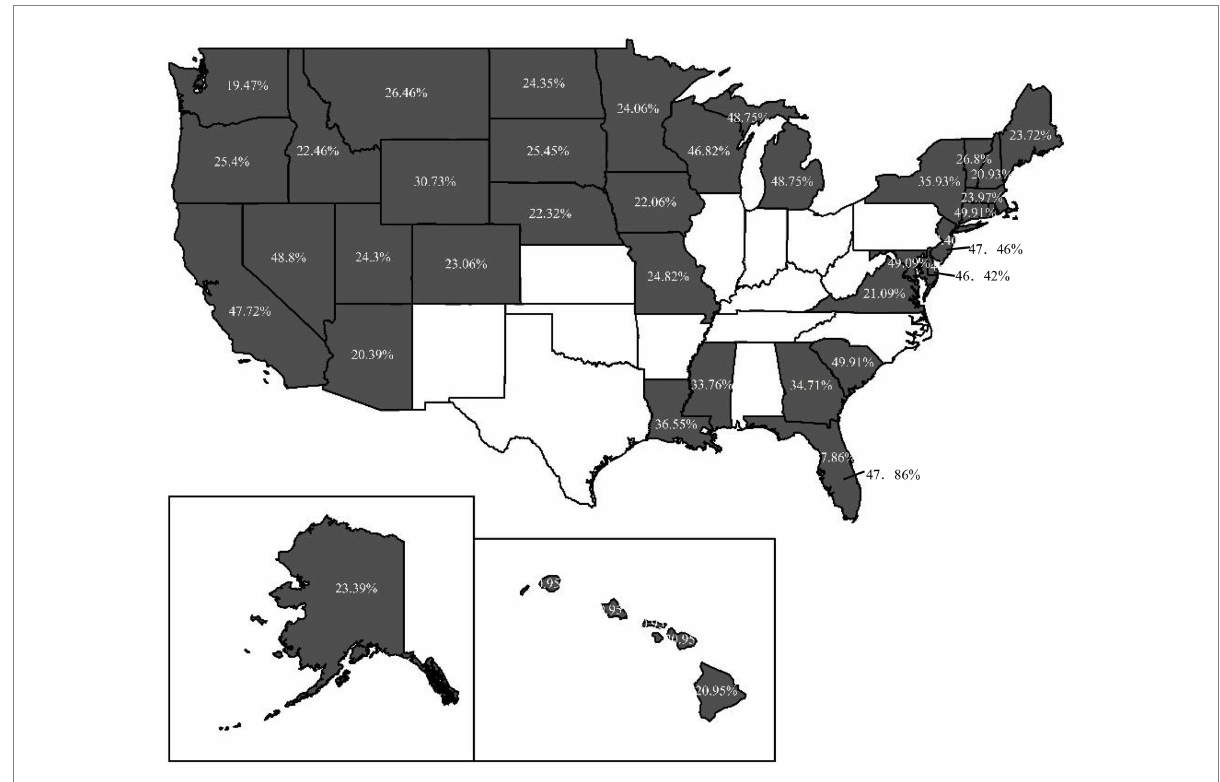
FIGURE 3 The distribution of the proportion of respondents with Y = 1 in 2009.